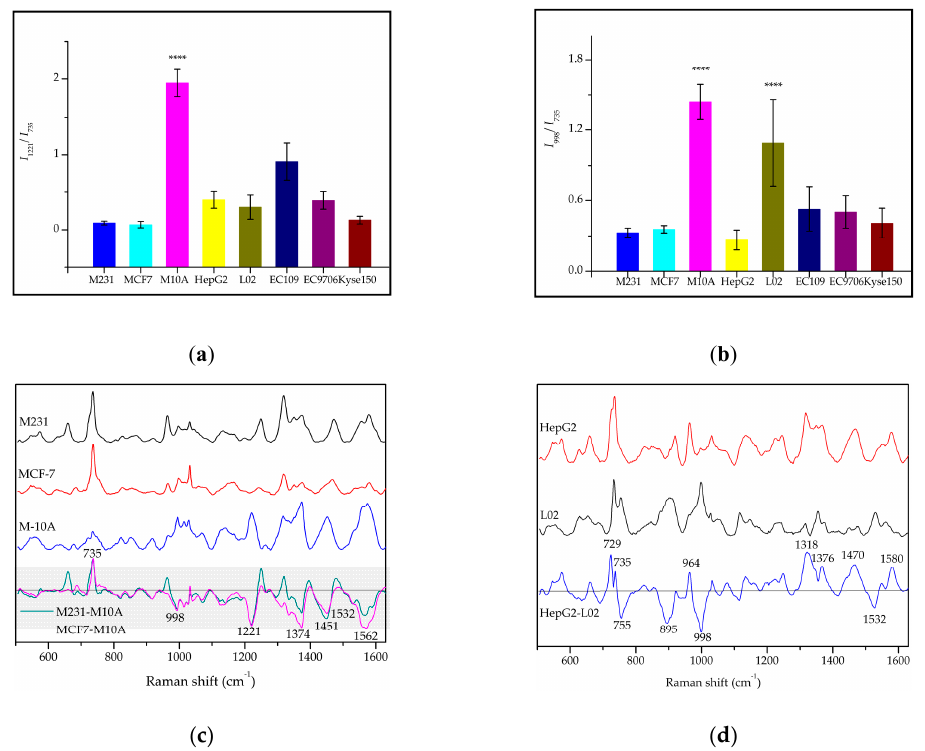
Figure 4. The differences between exosomal and cancerous SERS phenotypes. The relative Raman peak intensity ratio of eight different exosomes at I 1221 / I 735 ( a ), and I 998 / I 735 ( b ); ( c ) The differential spectra between breast cancer cell-derived exosomes and normal breast cell-derived exosomes; ( d ) The differential spectra between liver cancer cell-derived exosomes and normal liver cell-derived exosomes. Note: ****: p < 0.0001.